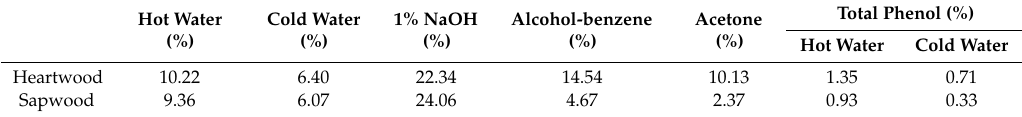
Table 3. Contents of partial extractives in heartwood and sapwood of